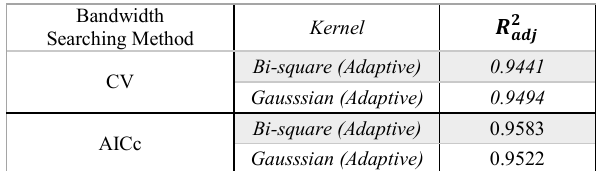
Table 4. Comparison of different variable